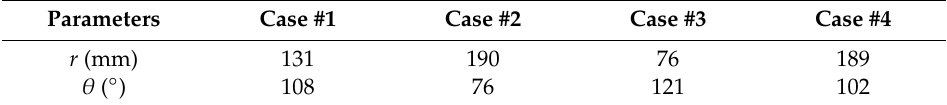
Table 2. Polar coordinates of actual impacts applied.